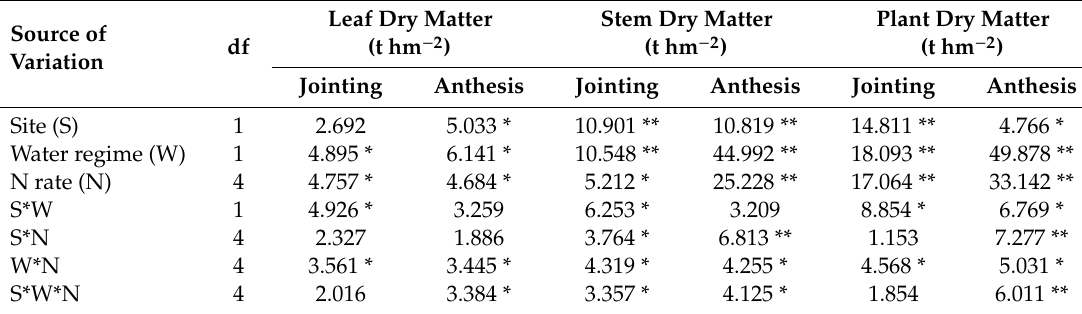
Table 2. The e ff ects of site, N rate, and water regime on tissue dry